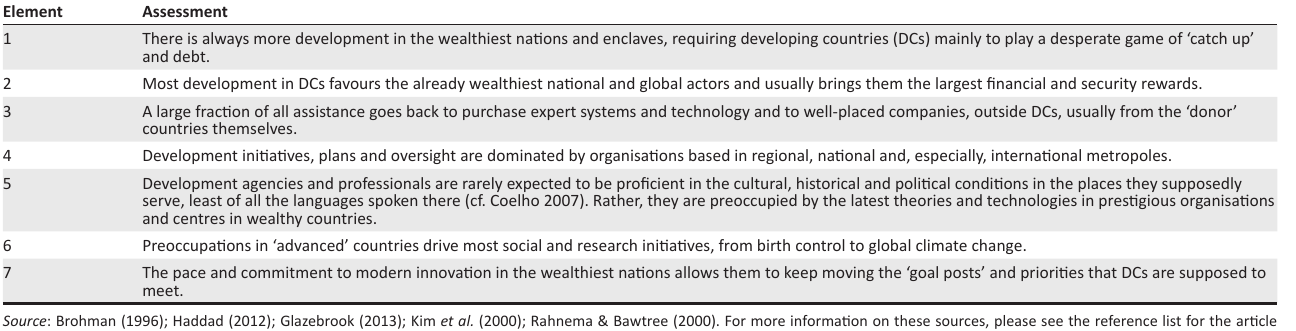
TABLE 2: Countervailing features and conditions of ‘development’ tending to disadvantage developing countries.